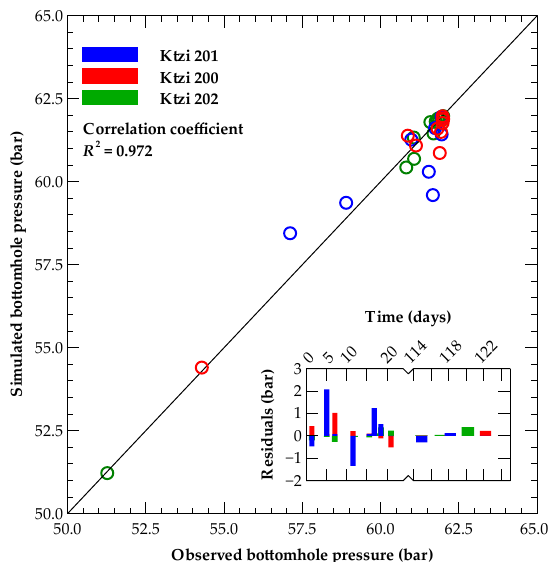
Figure 2. Flow rates as well as observed and simulated bottomhole pressure drawdown in the wells Ktzi 200, Ktzi 201 and Ktzi 202 in the hydraulic testing phase. Solid lines indicate applied flow rates and dashed lines the observed pressure drawdown, while circles represent the flow rates applied in the reservoir simulator and diamonds the simulated pressure response of the calibrated static reservoir model.